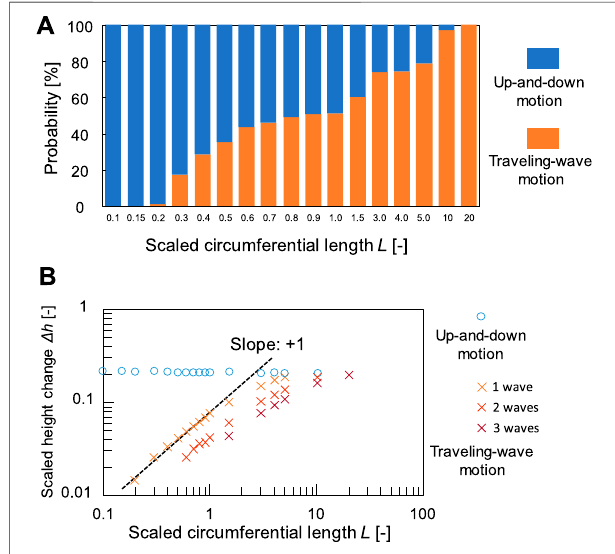
FIGURE 6 | Calculation results. (A) Relationship between probability of occurrence of the two modes and scaled circumferential length L and (B) double logarithmic plot of height change Δ h and L . For the traveling-wave motion,thenumberofformedwaves( n TW )isdifferentforeachtrial.Thus, theplotsof (B) aredividedintothreemarksdependingon n TW forthetraveling- wave motion. The plot for n TW ≥ 4 was